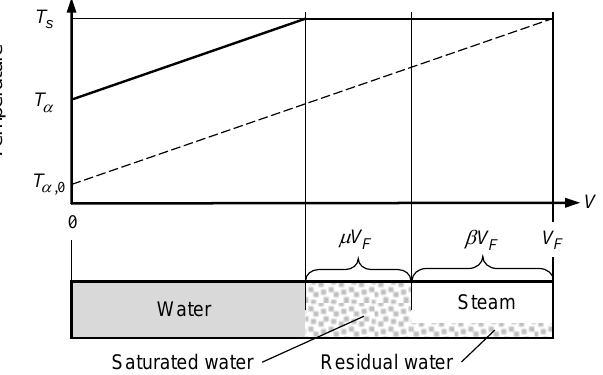
Figure 7. Thermodynamic states within a stagnating collector field during displacement. Liquid displacement happens simultaneously in the upper header, the lower header and the meander tube. It is therefore not necessary to distinguish between these three regions. This allows the description of the processes of displacement and steam generation in one dimension as a function of the volume, V